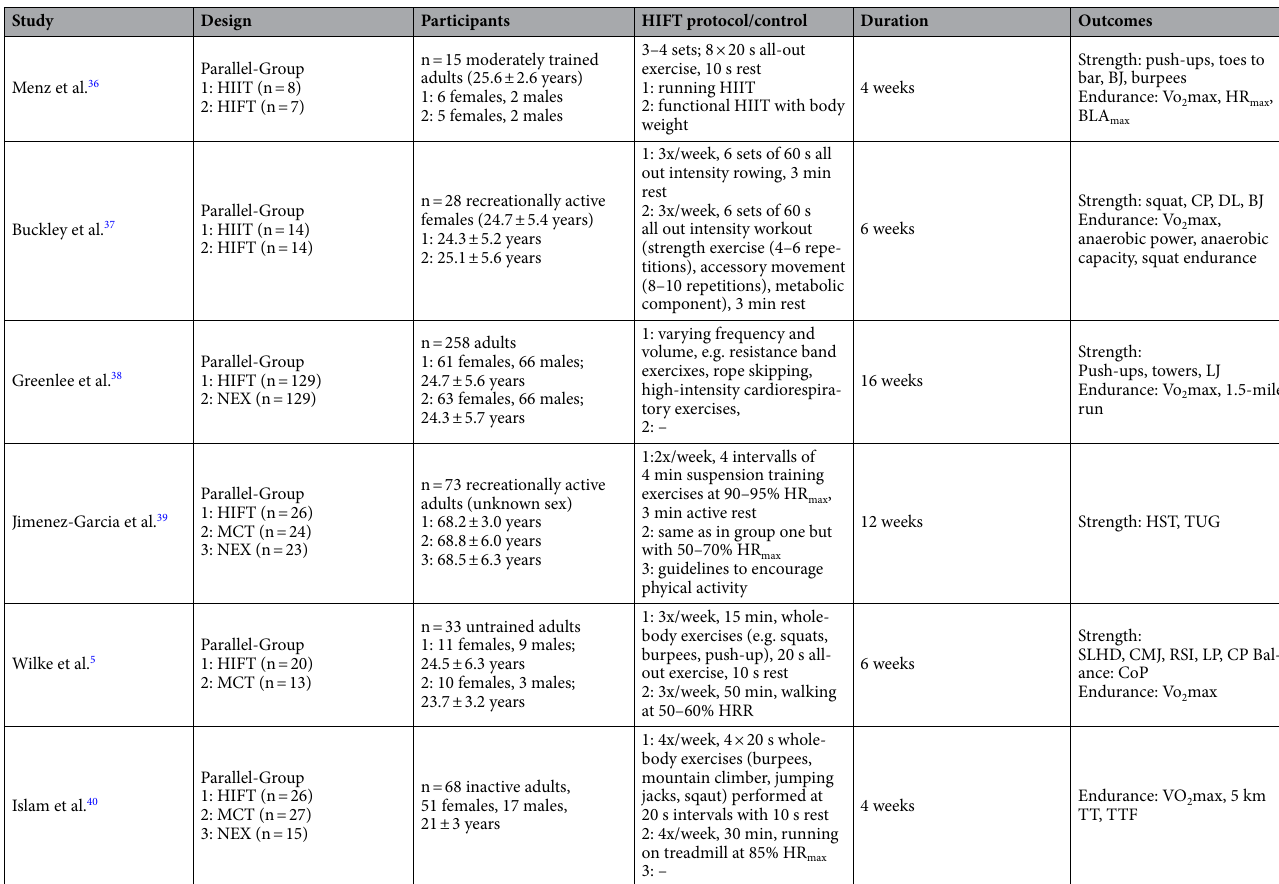
Table 1. Characteristics of the included studies. Age data are means ± standard deviations. HIFT high- intensity functional training, MCT moderate continuous training, NEX no exercise, min minutes, s